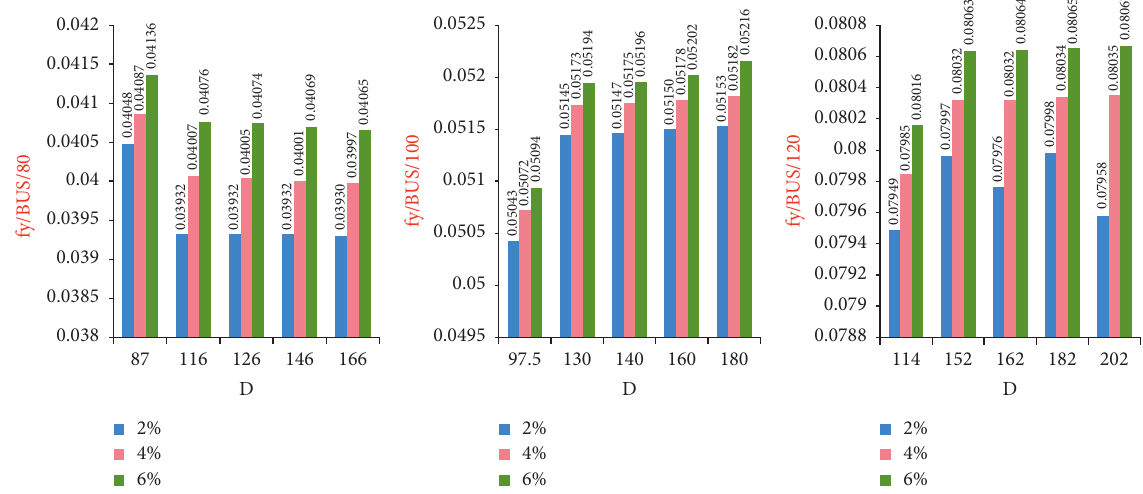
Figure 4: The lateral friction coefficient changes with direct distance change at upgrade and speeds of 80, 100, and 120 (km/h).